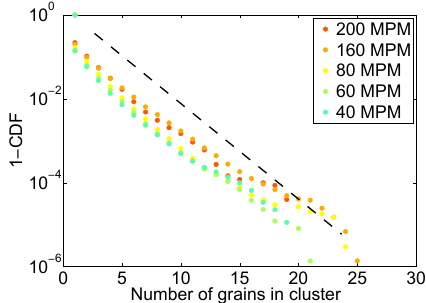
Figure 9. Complementary cumulative distributions of mobile clus- ter sizes, for each experiment at a different driving frequency. A cluster is defined as a group of mobile particles moving together in space. The dashed black line is an exponential trend, plotted for the sake of comparison. Note logarithmic y